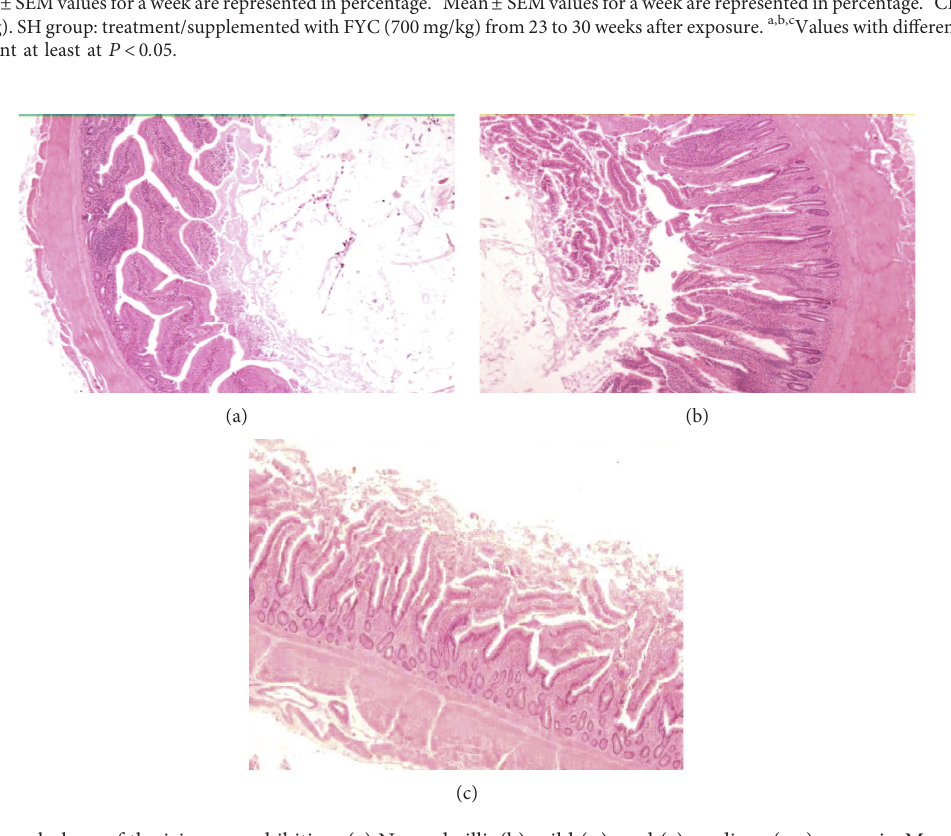
Figure 1: Histomorphology of the jejunum exhibiting. (a) Normal villi, (b) mild (+), and (c) medium (++) necrosis. Magnification: 400x.